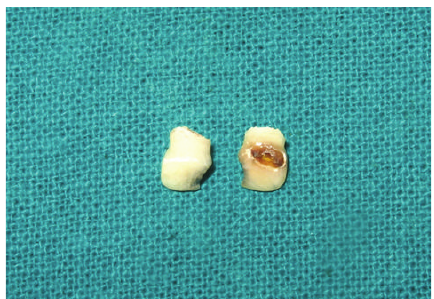
Figure 2: Extracted teeth.